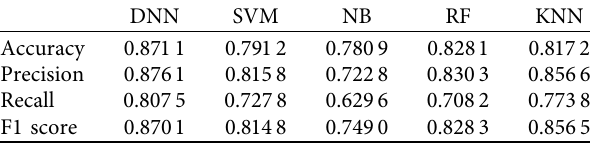
Table 3: Performance of the classification algorithms.